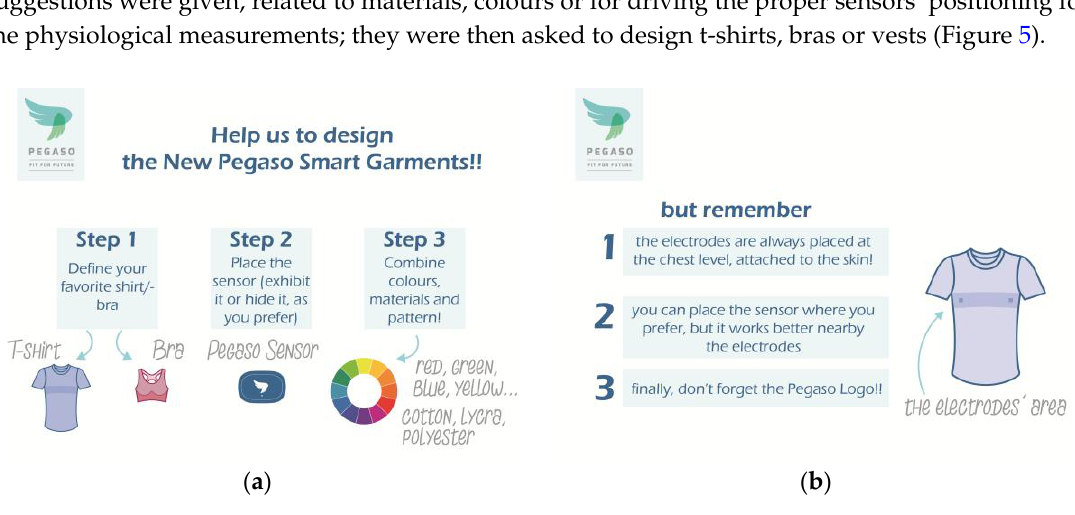
Figure 5. The co-design rules and related suggestions to comply with basic requirements: ( a ) the three-step development design activity explained to the teenagers; ( b ) the three fixed points imposed by the technical and functional requirements for signal monitoring and project dissemination.